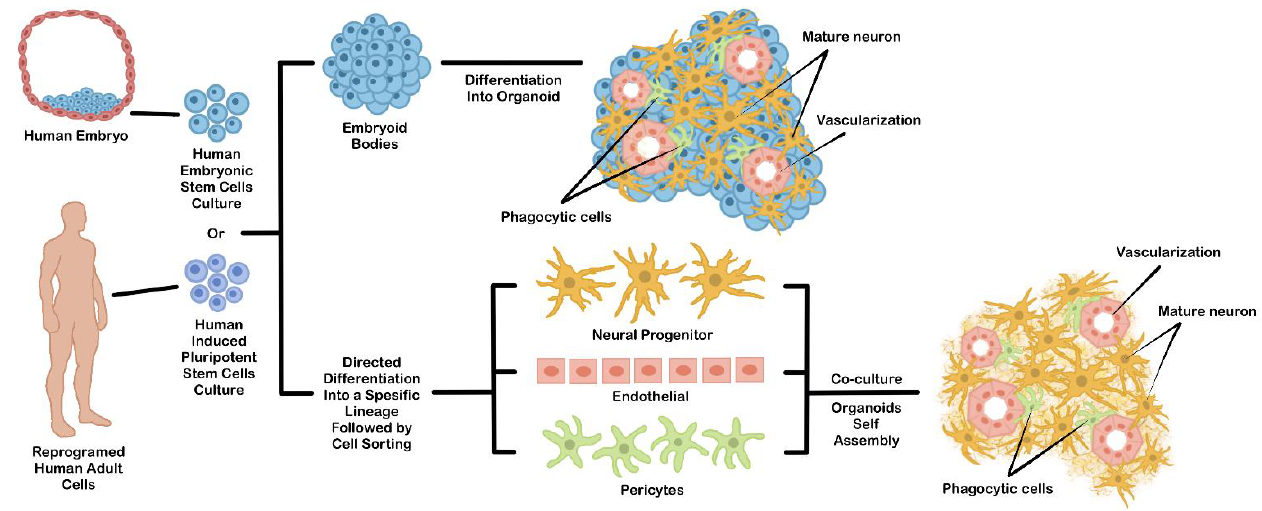
Figure 1. An example of general strategies used to generate hPSCs-derived brain organoids. This organoid can be generated directly from differentiated EBs (upper chart) or by coculture from independently differentiated hPSCs-derived cell types (lower chart).